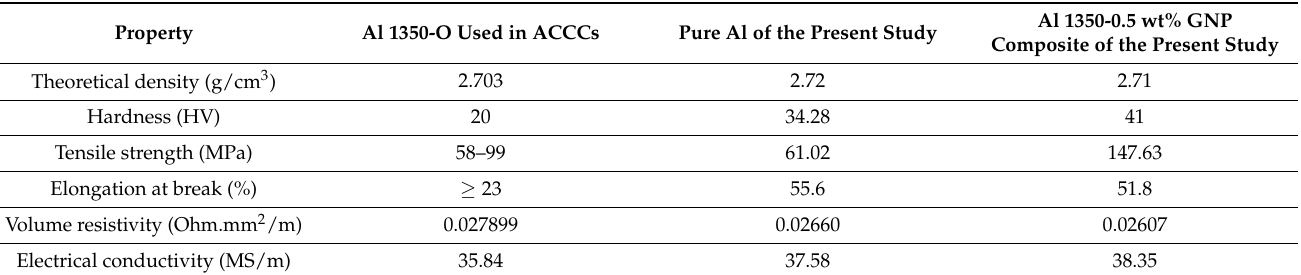
Table 5. Electrical conductivity and mechanical properties of Al 1350-O used in conductors, pure